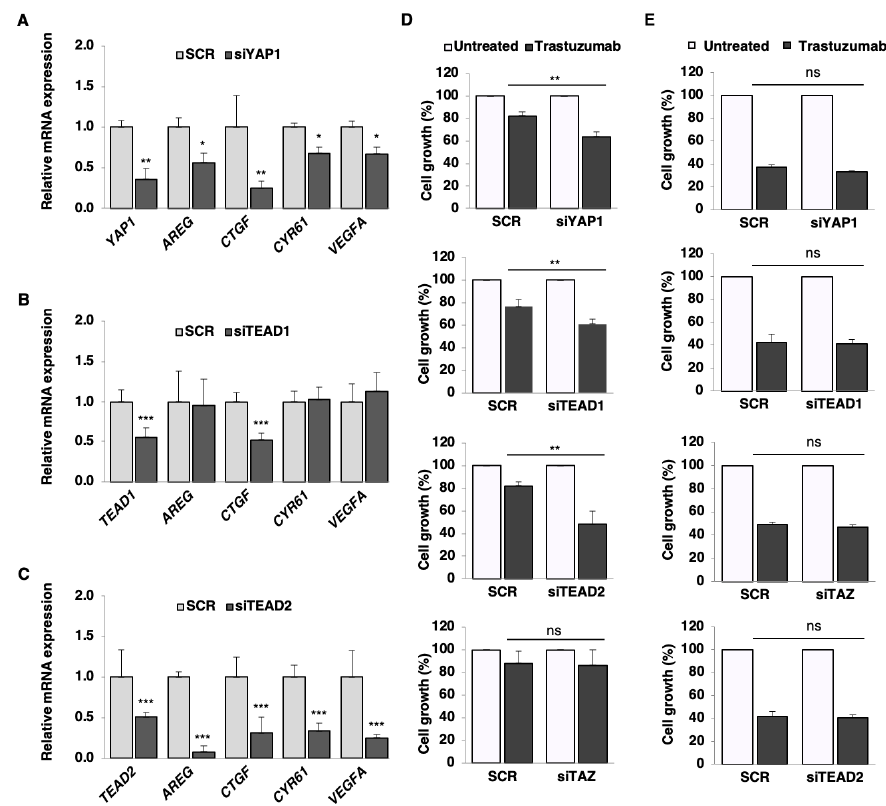
Figure 5. YAP1, TEAD1, and TEAD2 regulate the response to anti-HER2 inhibitor trastuzumab in BT-474.r2T cells by downregulation of specific downstream targets. ( A ) mRNA relative expression levels of YAP1 and its targets AREG , CTGF , CYR61, and VEGFA after YAP1 silencing in the BT-474.r2T cell line. ( B ) Quantitative analyses of mRNA relative expression levels of TEAD1 and YAP1-TEAD targets after TEAD1 silencing. ( C ) qPCR analysis of TEAD2 mRNA expression levels and YAP1-TEAD targets after TEAD2 silencing. ( D ) Validation of the e ff ects of either YAP1, TEAD1, TEAD2, or TAZ knockdown (siRNA) on sensitivity to trastuzumab in the trastuzumab-resistant BT-474.r2T cell line. Cell proliferation was measured after 7 days of exposure to 15 µ g / mL trastuzumab. Assessment of cell growth by trypan blue exclusion cell viability assays is shown, with quantification for each condition relative to cells expressing the scrambled control siRNA. ( E ) Validation of the e ff ects of YAP1, TEAD1, TEAD2, and TAZ knockdown on sensitivity to trastuzumab in the trastuzumab-sensitive BT-474 cell line. In all graphs, *: p < 0.05, **: p < 0.01, ***: p < 0.001.